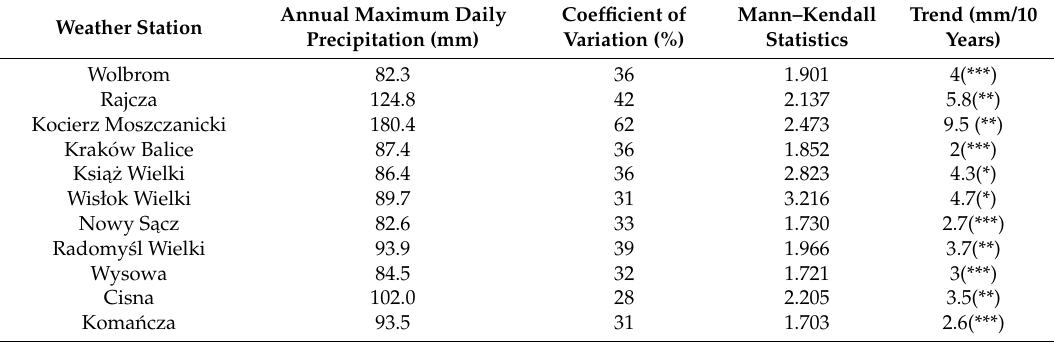
Table 1. Statistical parameters of the annual maximum daily precipitation and trend values